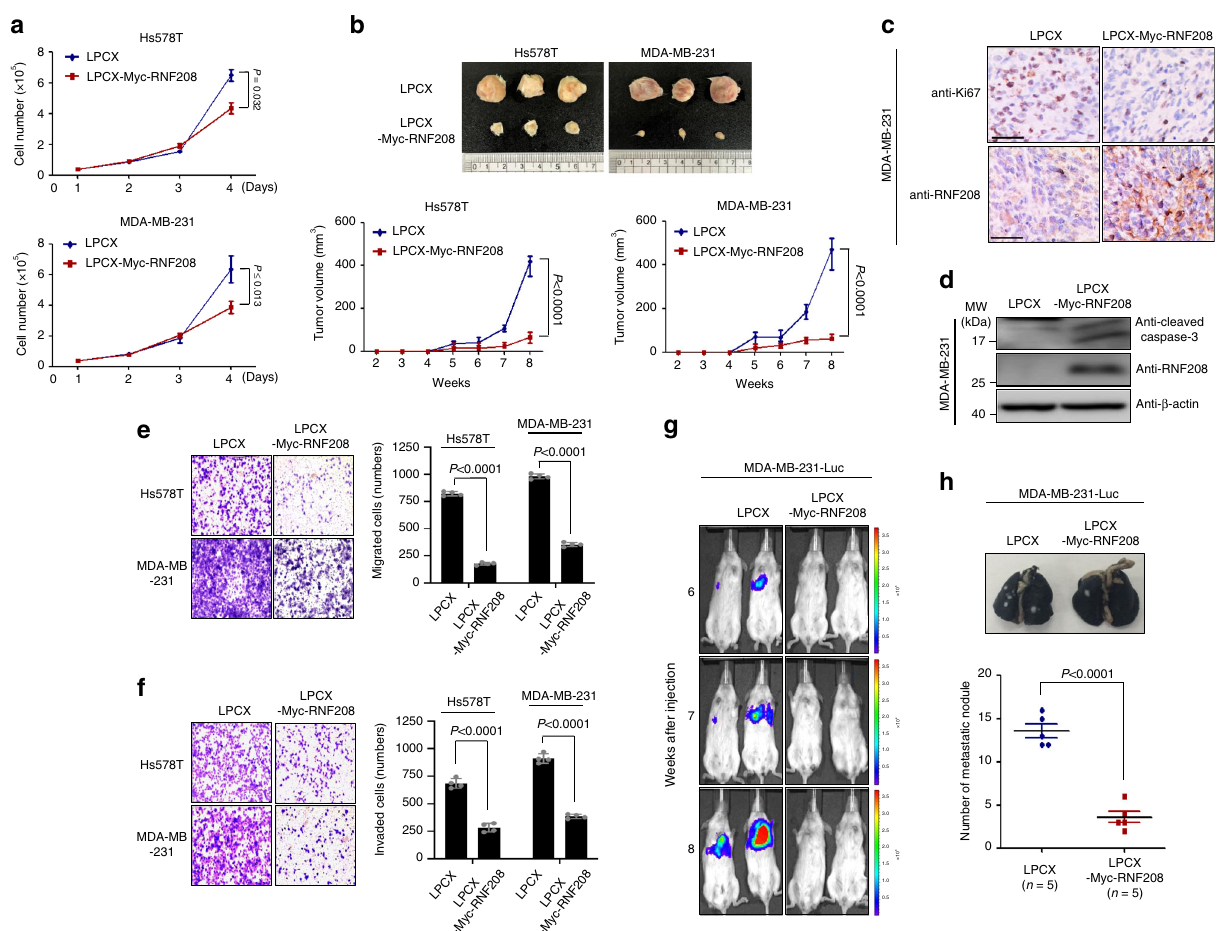
Fig. 3 Overexpression of RNF208 reduces tumorigenesis and lung metastasis in TNBC cells. a Cell doublings of RNF208-overexpressing Hs578T and MDA-MB-231 cells. Each point represents the mean of cell numbers counted in triplicate dishes. b Tumor formation and growth of control and RNF208- overexpressing TNBC cells subcutaneously injected into the fl anks of NOD/SCID mice ( n = 6 per group). Primary tumor volumes were measured weekly, and mice were sacri fi ced at 8 weeks (Hs578T and MDA-MB-231). Representative primary tumor images (top) and tumor volumes (bottom) are shown. c Representative IHC image showing Ki-67 and RNF208 expression in primary tumor tissues from ( b ). Original magni fi cation ×100. Scale bar, 100 μ m. d Immunoblot analysis of active caspase-3 expression using lysates of RNF208-overexpressing MDA-MB-231 cells. β -actin was used as an internal control. e , f Transwell migration and Matrigel invasion assays of TNBC cells stably expressing RNF208 proteins. After 24 h, migrated ( e ) and invaded ( f ) cells were counted following staining with crystal violet. g Representative bioluminescent (BLI) imaging of NOD/SCID mice ( n = 5 per group) showing lung metastasis from 6 to 8 weeks, derived from lateral tail-vein injection of control and RNF208-overexpressing MDA-MB-231-Luc. h Representative whole lung image stained with India ink showing metastatic nodules (top) and scatter plot showing the number of lung metastatic nodules (bottom). All P values were calculated by unpaired two-tailed Student ’ s t tests ( a , b , and h ). The data represent the mean ± SD. Source data for ( a , b , e , f , h ) are available in Source Data fi le. Unprocessed original scans of blots and gels in ( d ) is shown in Supplementary Fig.